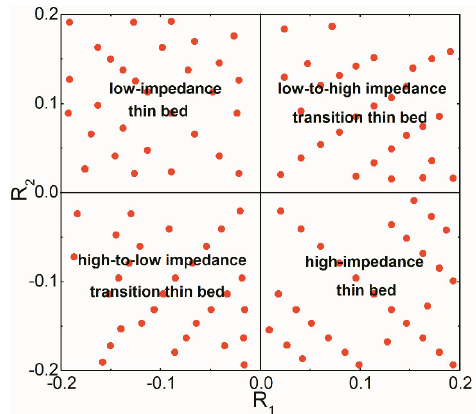
Figure 9. R 1 and R 2 distributions of 120 thin-bed models.